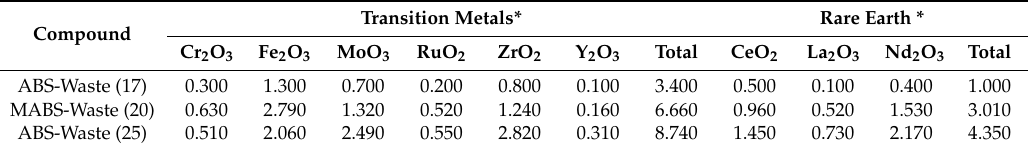
Table 4. Chemical composition of the studied glasses (waste components: transitions and rare earth